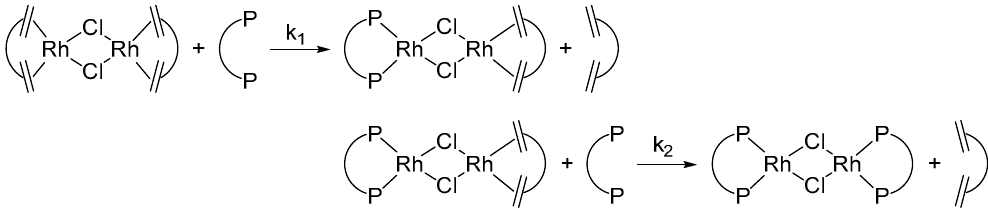
Scheme 4. Sequence of the competing consecutive reactions leading to [Rh(disphosphine)( µ 2 -Cl)] 2 from [Rh(diolefin)( µ 2 -Cl)] 2